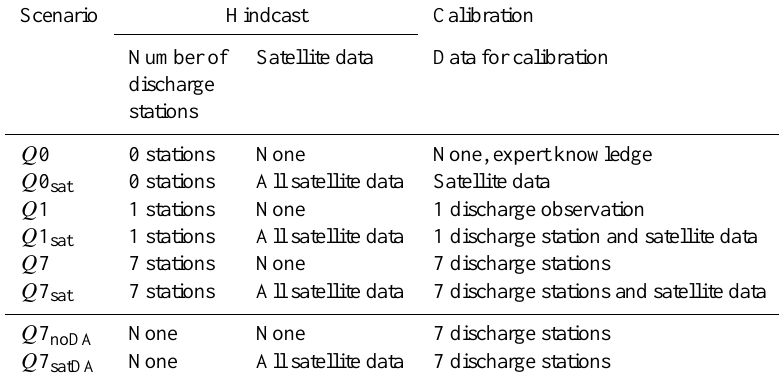
Table 1. Hindcasting scenarios for the EFAS system including abbreviations and assimilated data used to create a re-analysis time series from which hindcasts were initiated. The calibration indicates the data used by Wanders et al. (2013) to calibrate the hydrological